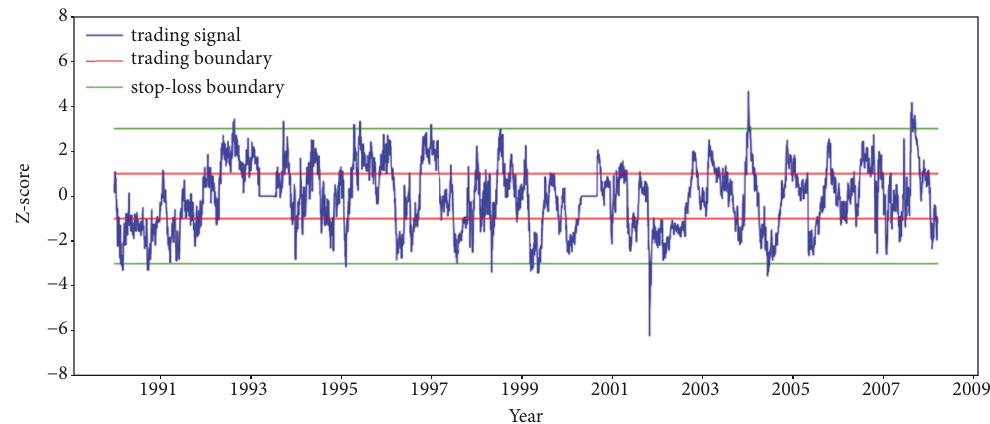
Figure 1: The traditional pairs-trading